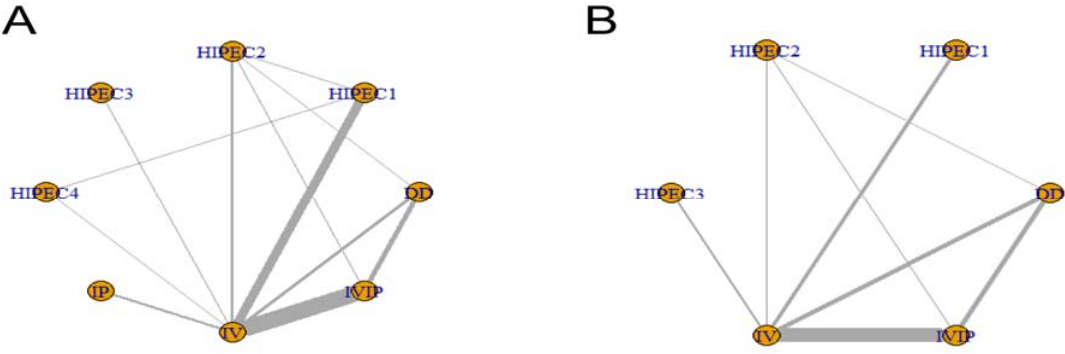
Figure 2. Network map of OS ( A ) and PFS ( B